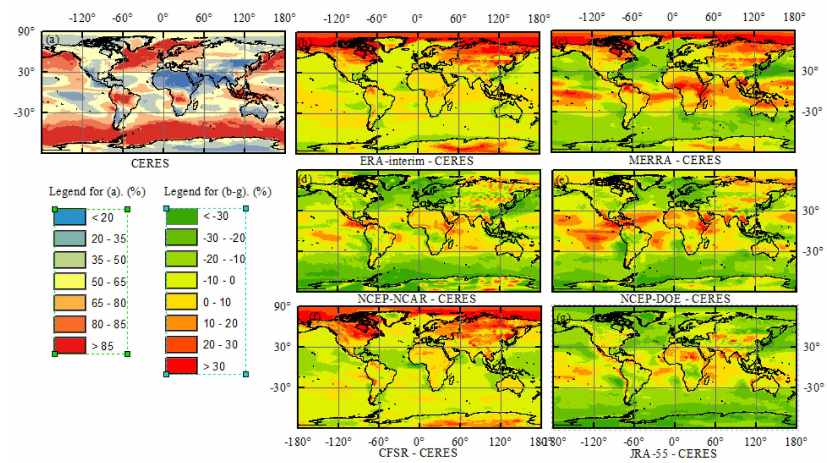
Figure 6. CERES CF climatologies for DJF and the biases between the reanalyzed CF and the CERES CF (reanalysis minus CERES) from 2001 to 2009: ( a ) CERES monthly CF for DJF; ( b ) ERA-Interim minus CERES; ( c ) MERRA minus CERES; ( d ) NCEP-NCAR minus CERES; ( e ) NCEP-DOE minus CERES; ( f ) CFSR minus CERES; ( g ) JRA-55 minus CERES.